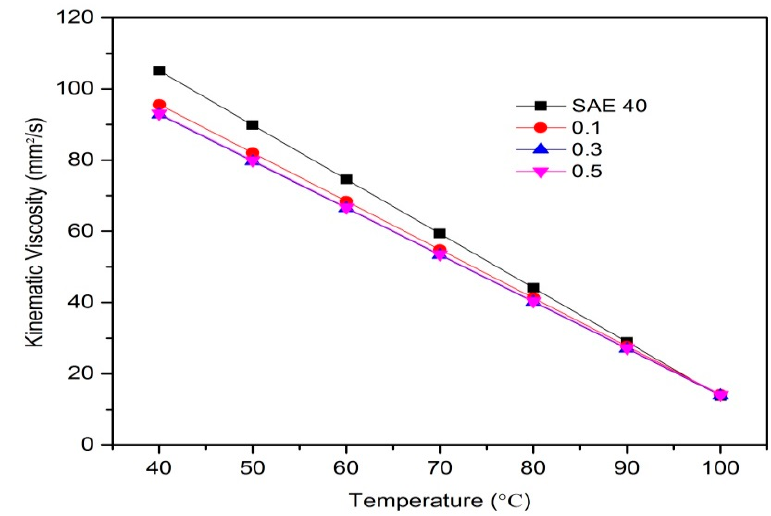
Figure 12. Kinematic viscosity of SAE 40 and different concentration of CNC-CuO nanolubricant.